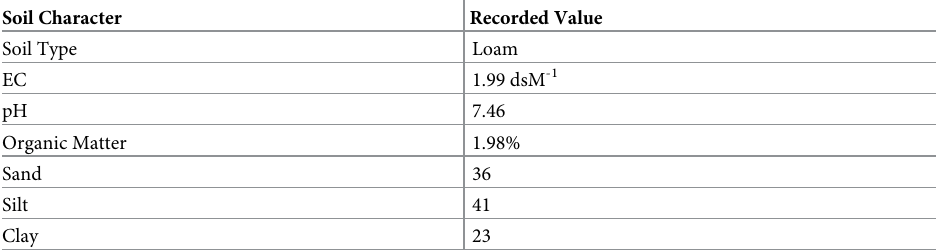
Table 1. Characteristics of experimental soil used for rice